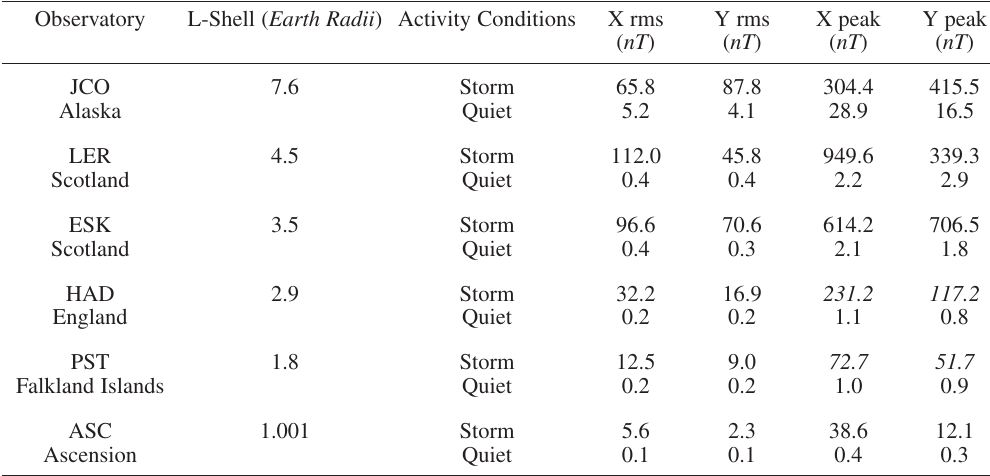
Table I. RMS and peak amplitudes for the six observatory filtered series shown in fig. 9 (18:00 - 00:00 UT on 30th October 2003, when ap = 400, 400), compared to a quiet period from the same month (18:00 - 00:00 UT on 27th October 2003, when ap = 5, 4). North (X) and east (Y) geocentric amplitudes are given. Observatory L-Shell ( Earth Radii ) Activity Conditions